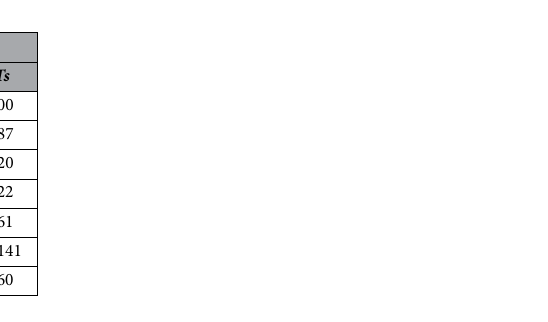
Table 6. The numerical outcomes for Sherwood number − � ′ ( 0 )